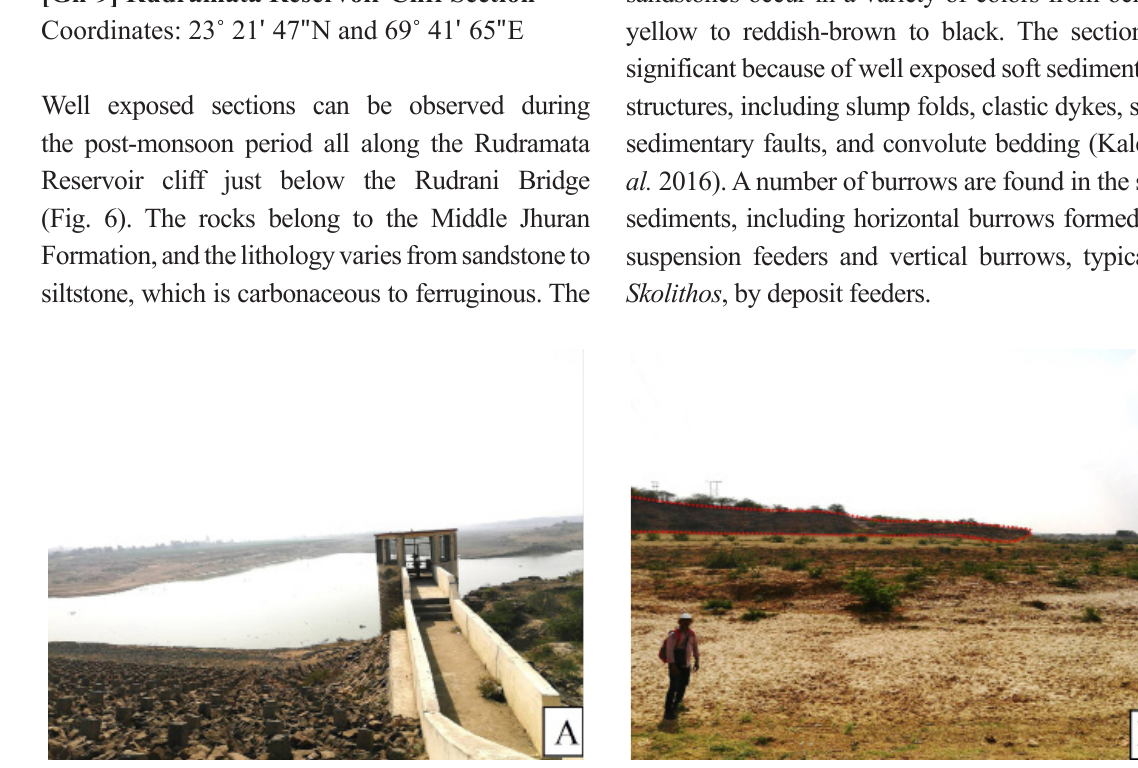
Figure 6. Rudramata Reservoir. A) The reservoir. B) Dried Khari River valley during the month of